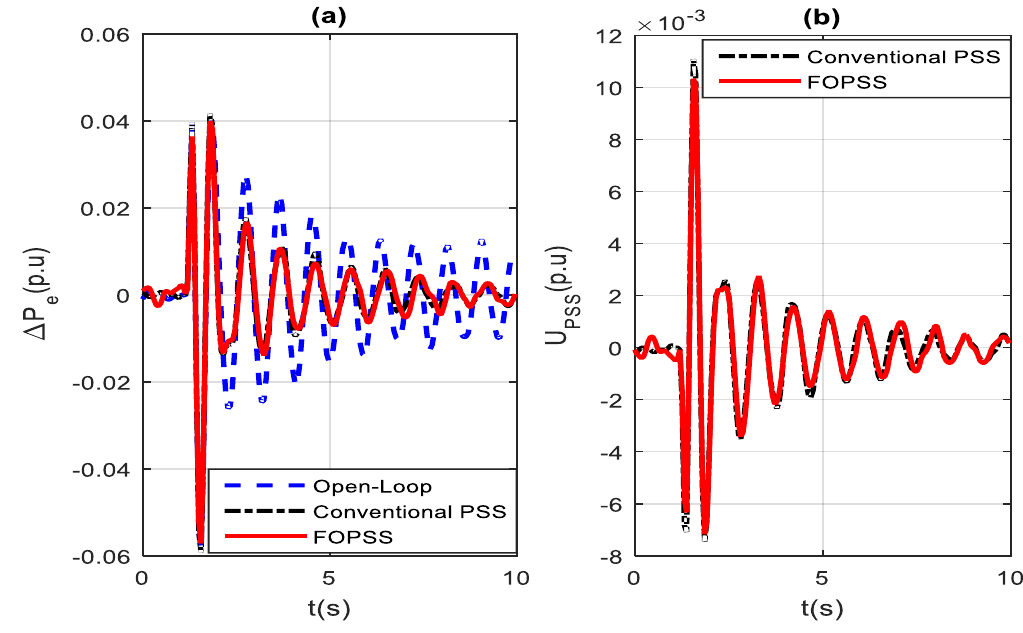
Figure 12. ( a ) Active power deviation response; and ( b ) control effort at 0.1 p.u. operation point.